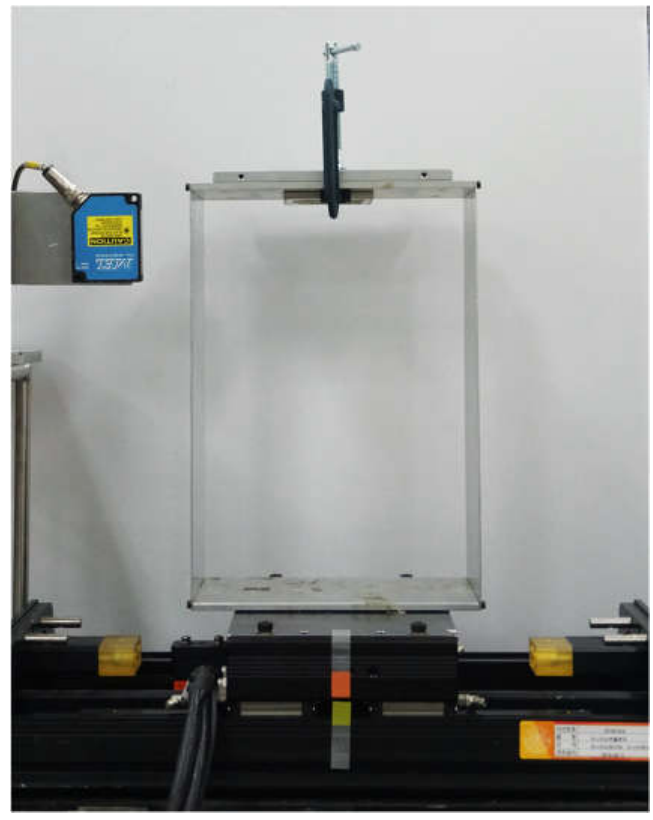
Figure 7. Experimental testbed.